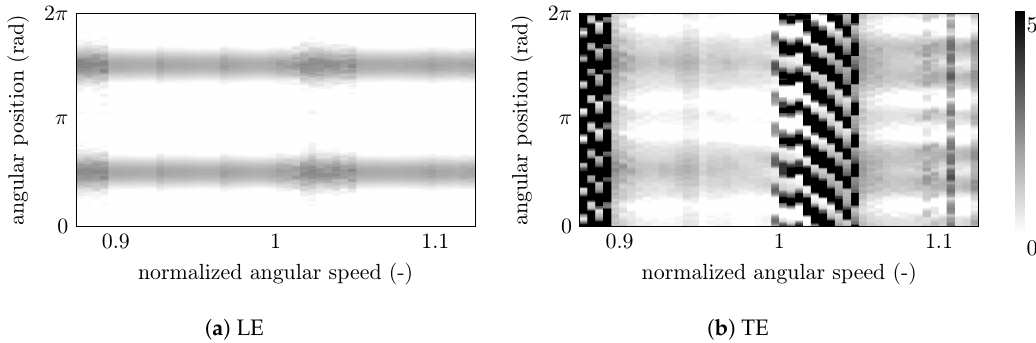
Figure 25. Evolution of the wear profile with the angular speed for the LP compressor blade.